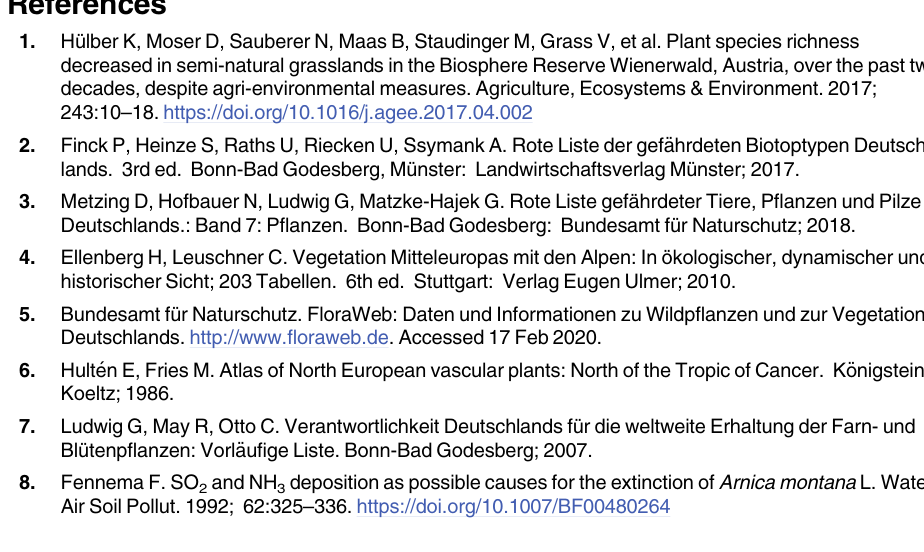
S4 Table. Data from the greenhouse experiment. Shown are height and width measurements after 90 and 150 days for all seedlings grouped by box as well as the assigned treatment levels for the corresponding box